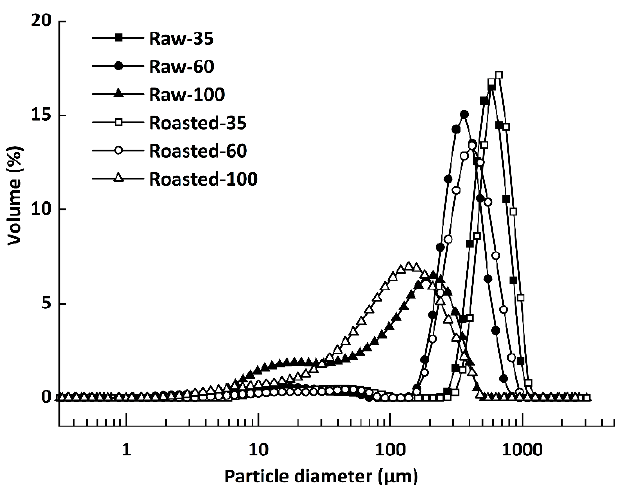
Figure 1. Particle size distribution of raw and sand-roasted highland barley flours. Raw-35, Raw-60, and Raw-100 indicate raw highland barley flour as coarse (250–500 µ m), medium (150–250 µ m), and fine (<150 µ m) fraction, respectively; while Roasted-35, Roasted-60, and Roasted-100 indicate sand-roasted highland barley flour as coarse (250–500 µ m), medium (150–250 µ m), and fine (<150 µ m) fraction, respectively.